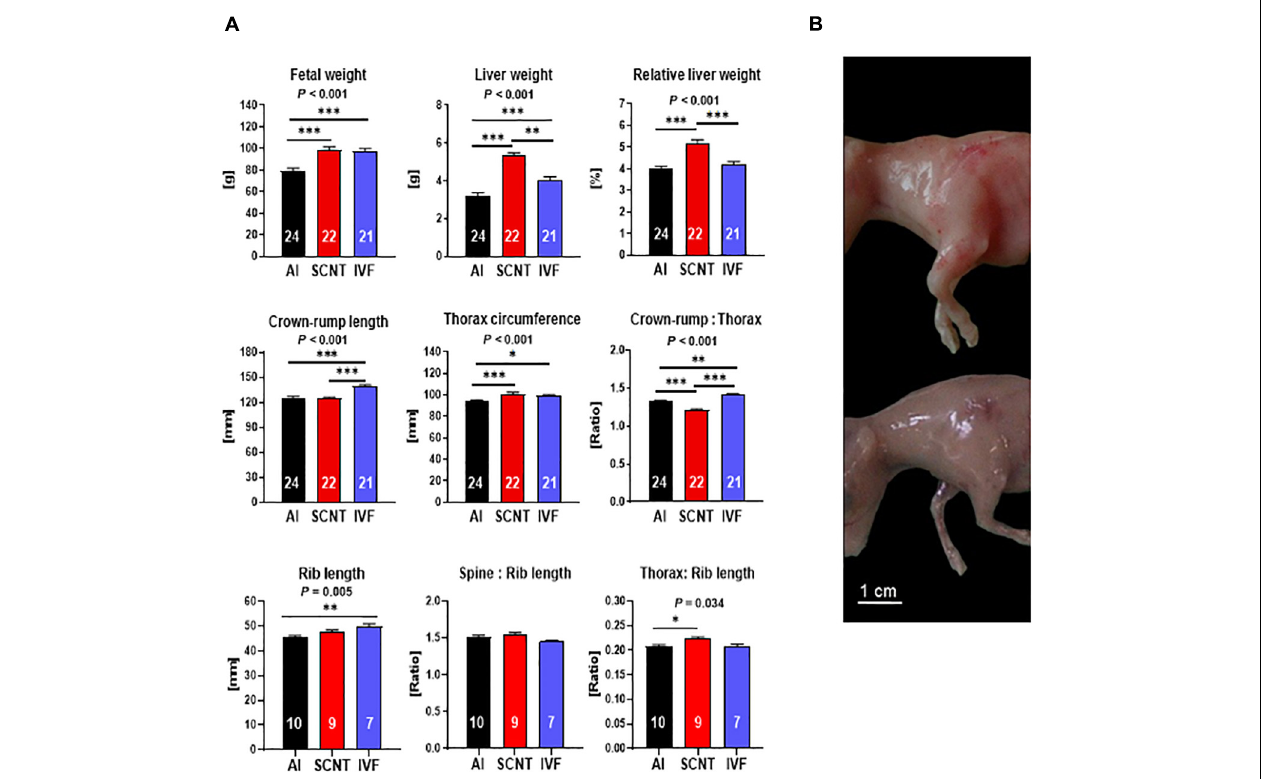
FIGURE 1 | Abnormal phenotype after somatic cell nuclear transfer (SCNT) involves hepatomegaly and muscle hypertrophy. (A) Effects of SCNT on fetal phenotype as compared with in vitro fertilization (IVF) and artificial insemination (AI) controls at day 80 of gestation. Crown rump:thorax is crown-rump length to thorax circumference ratio, rib length is the combined length of both sixth ribs, spine:rib length is the ratio of the length of the spinal column to the combined length of both sixth ribs, and thorax:rib length is the ratio of thorax circumference to combined length of both sixth ribs. Means ± standard error of the mean (SEM) and P -values for significant effects of treatment (AI, IVF, and SCNT) on phenotypic parameters in ANOVA ( F -test) are shown. Significant differences between group means are indicated by asterisks ( t -test; ∗ P < 0.05, ∗∗ P < 0.01, ∗∗∗ P < 0.001). The number of fetuses analyzed for each parameter is given inside bars. (B) SCNT fetus displaying typical phenotype with increased muscle mass (top) compared to AI control